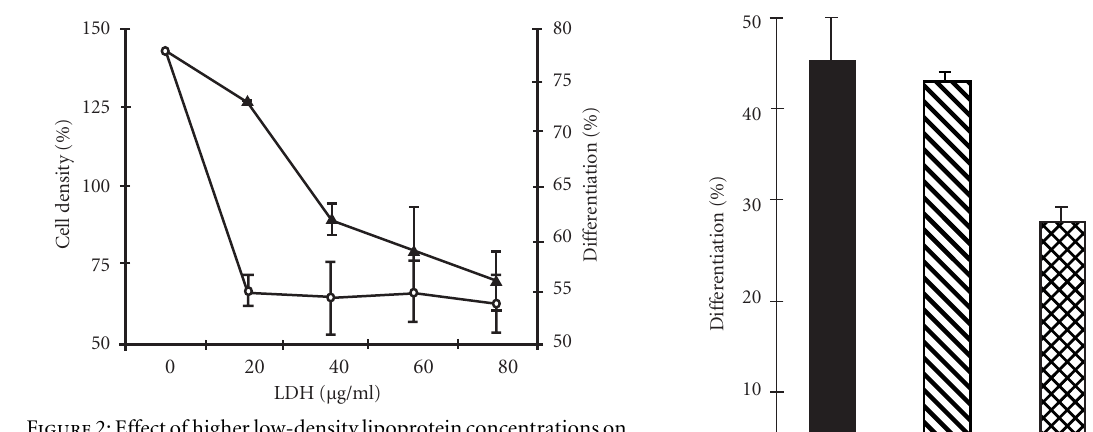
Figure 2:Effectof higherlow-densitylipoproteinconcentrationson growth and differentiation of HL-60 cells byATRA. HL-60 cells were incubated during 5 days with 1 µ MATRA and increasing concentra- tions of LDL. Differentiation as determined by NBT reduction ( ◦ ) and viable cell number as determined by Trypan blue exclusion ( (cid:1) ).